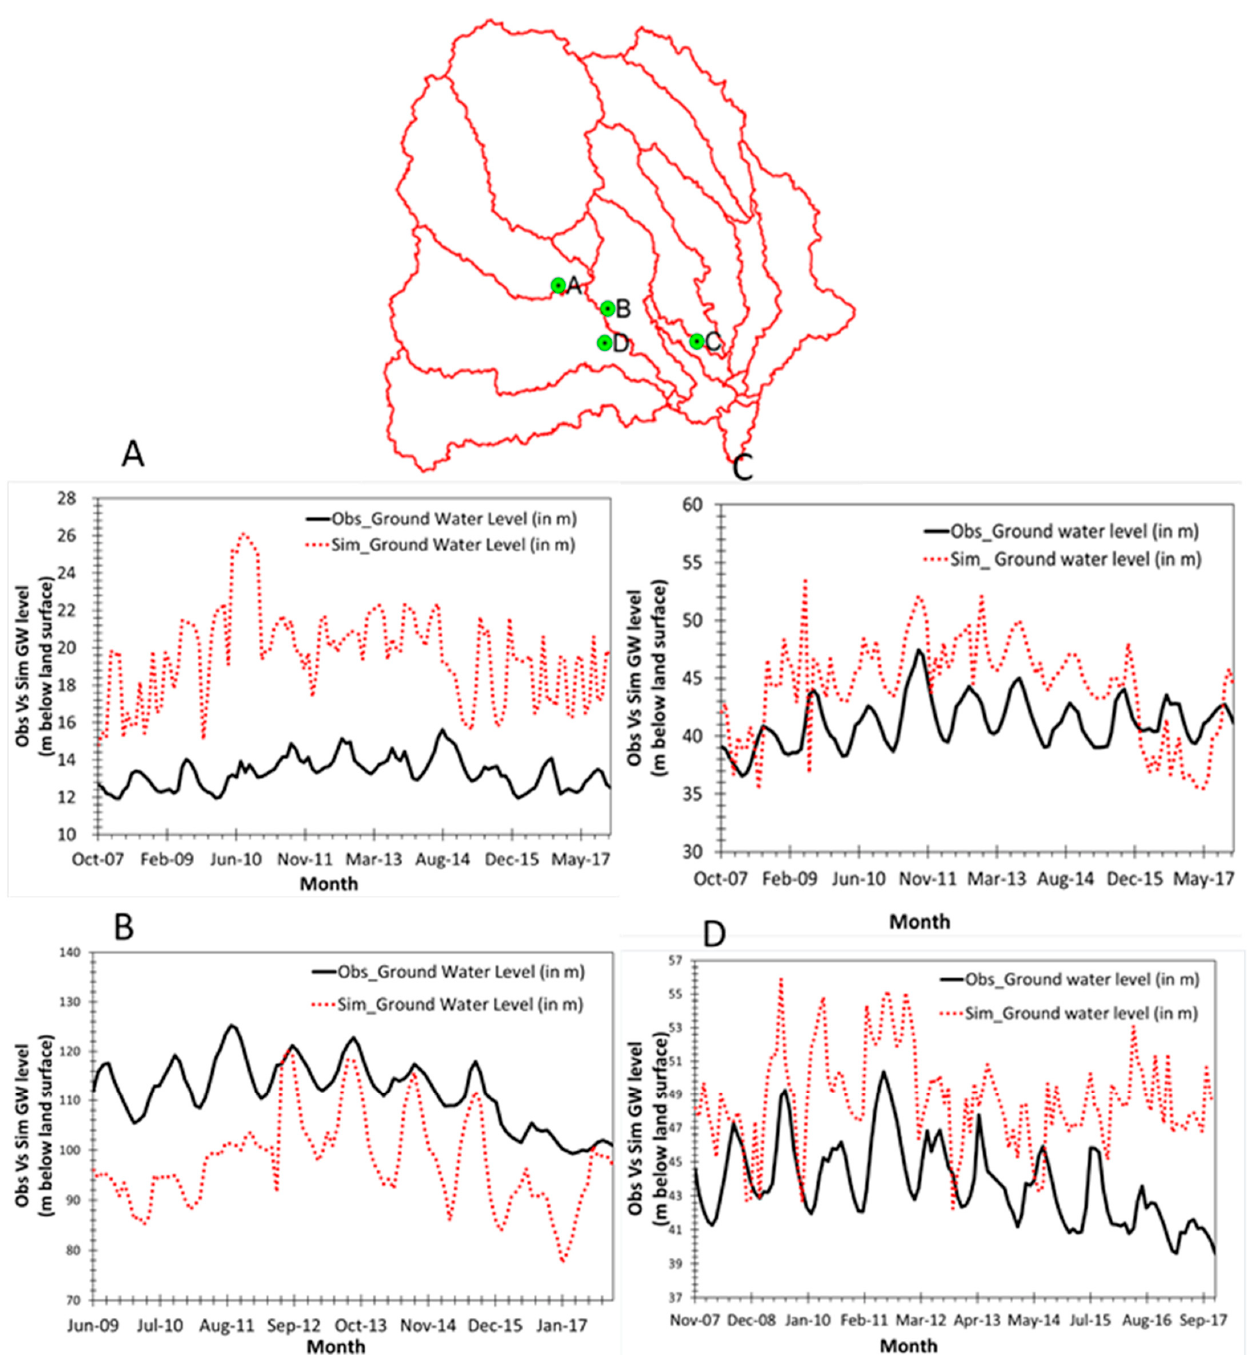
Figure 9. Time series plot showing the comparison of monthly observed Vs simulated water level (meter below land surface). ( A ). Observation Well 6044805; ( B ). Observation Well 6053516; ( C ). Observation Well 6055710 and ( D ). Observation Well 6053518.